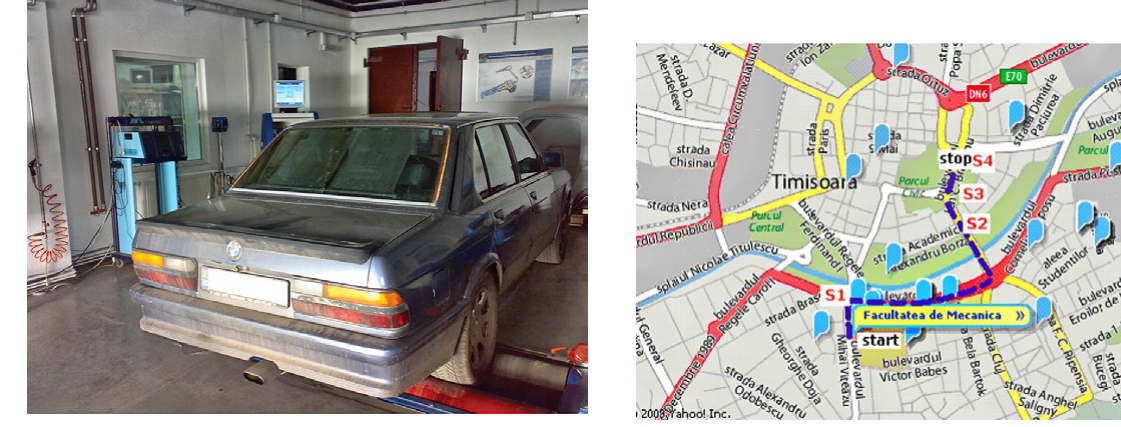
Fig. 2. Experimental model organization Fig. 4. The analyzed route